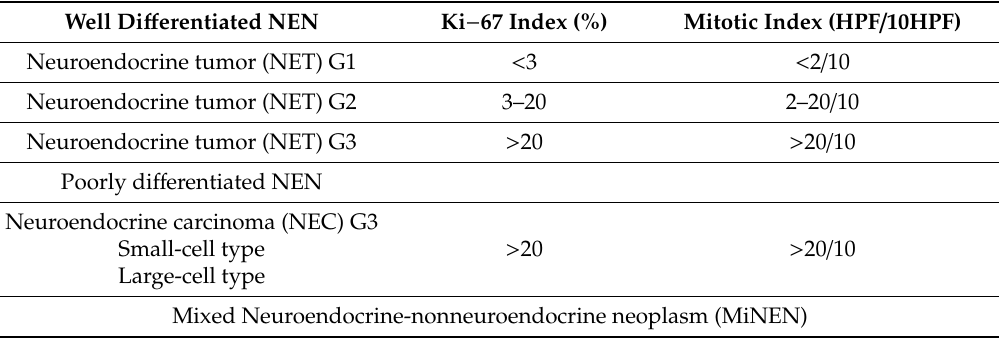
Table 1. The 2017 World Health Organization (WHO) Classification for Neuroendocrine Neoplasms (NEN) of the digestive